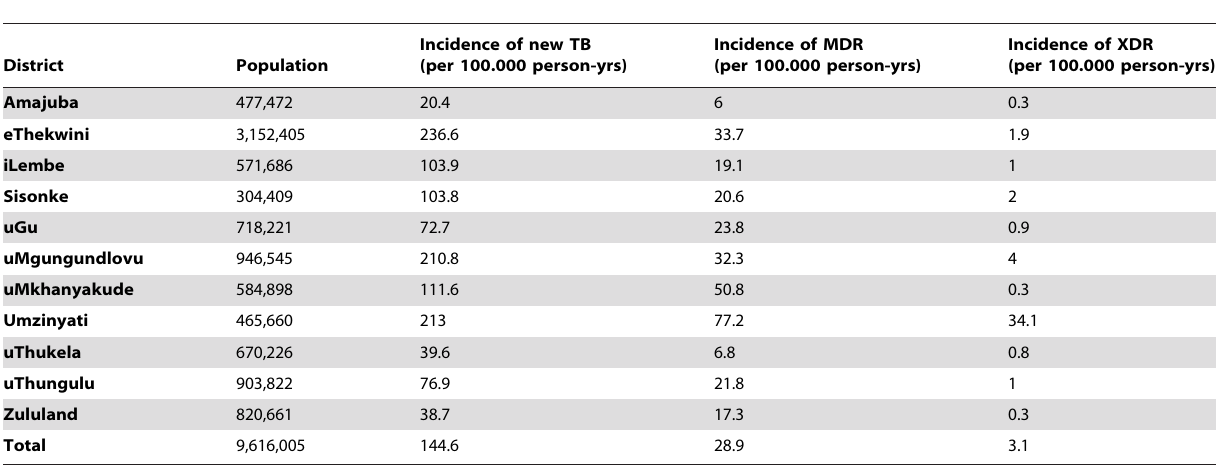
Table 1. Incidence of culture-confirmed cases of newly-diagnosed tuberculosis, MDR tuberculosis and XDR tuberculosis in the 11 health districts of KwaZulu-Natal